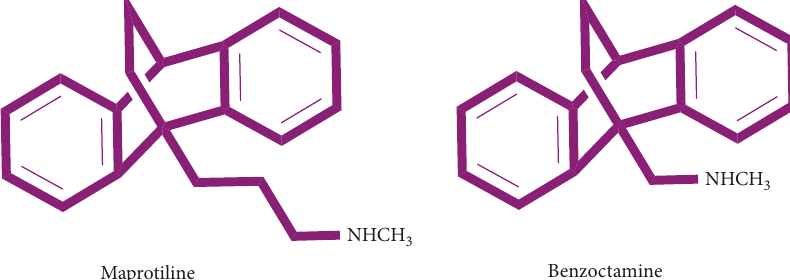
Figure 1: Structures of the ethanoanthracene pharmaceutical agents: maprotiline and